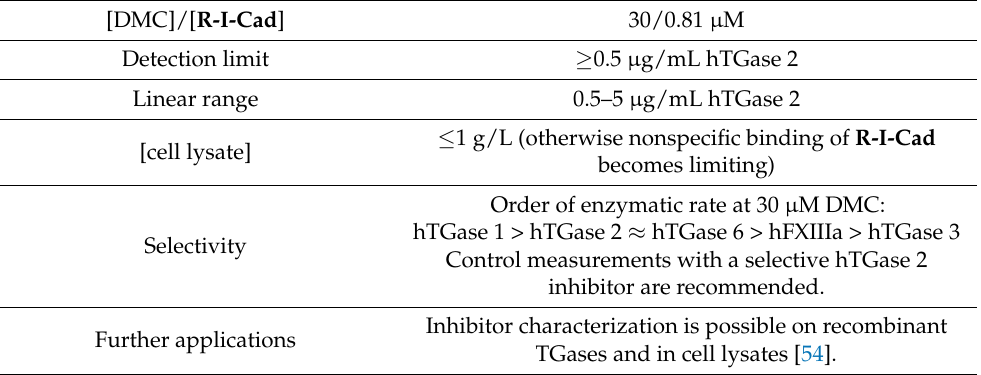
Table 3. Summary of key parameters for application of the FA-based assay in cell lysates.